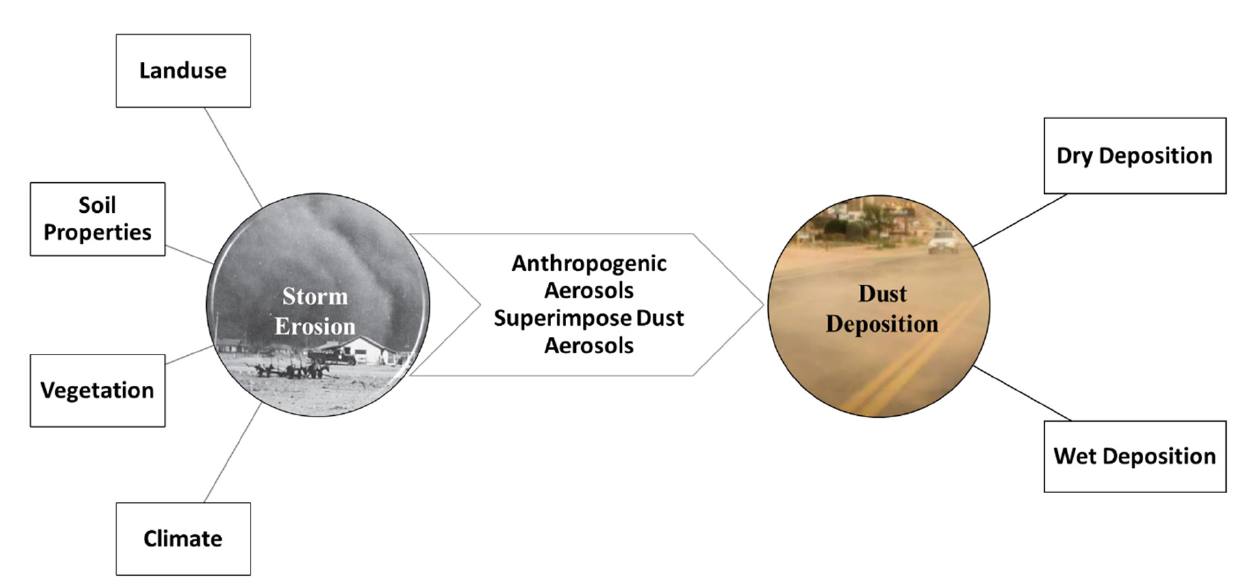
Figure 1. Key Factors Affecting Storm Erosion and the Principal Means of Dust Deposition.